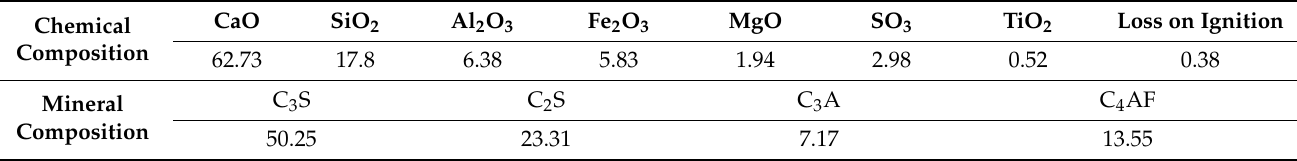
Table 2. Chemical compositions and mineral compositions of OPC (%).